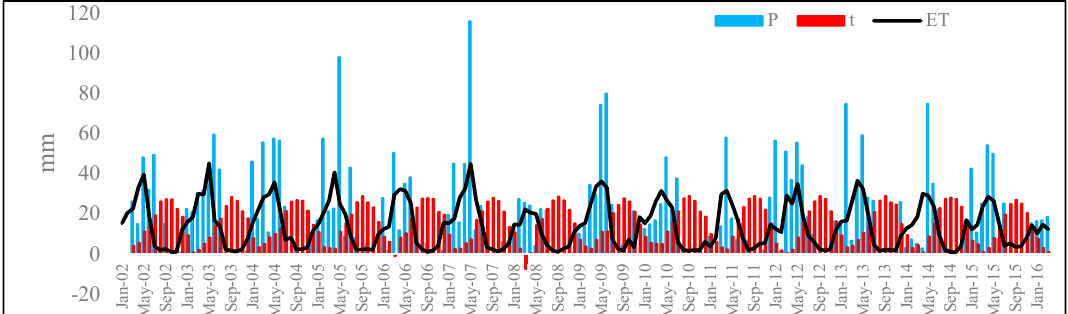
Figure 4. The precipitation, temperature, and evapotranspiration anomalies from 2002 to 2016.